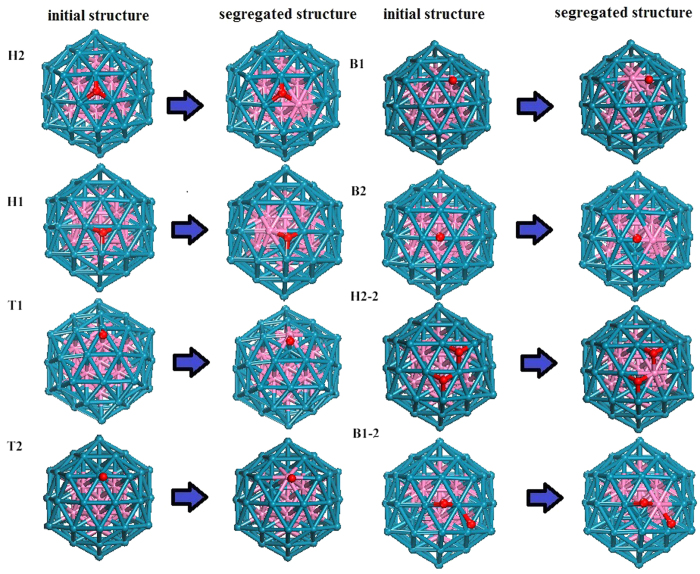
Adsorption of one or two O atoms on the W13@Pt42 core-shell structure.